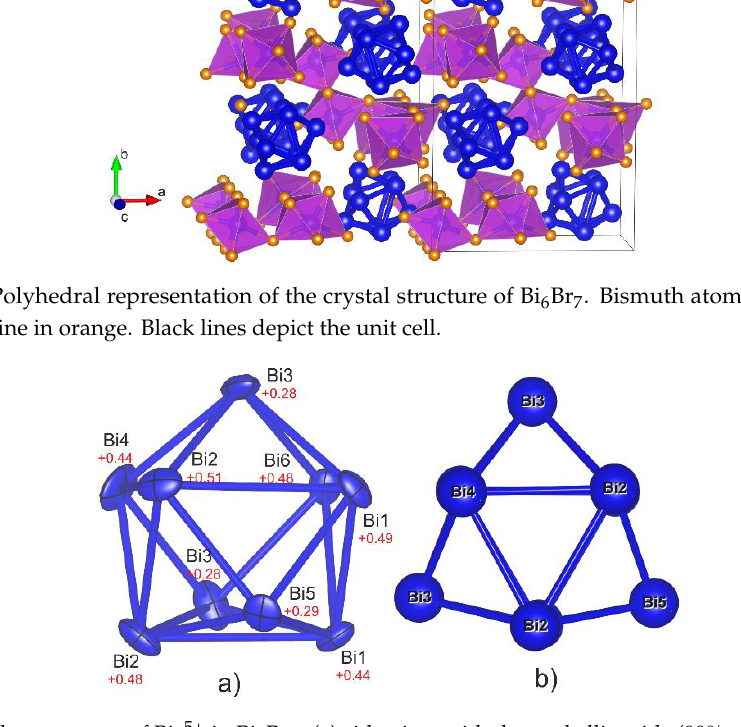
Figure 2. The geometry of Bi 95 + in Bi 6 Br 7 : ( a ) side view with thermal ellipsoids (99% probability) and atomic charges (in red); ( b ) a view down the three-fold axis.